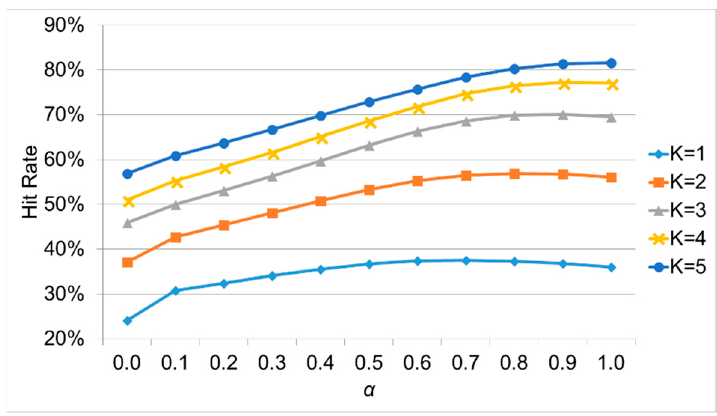
Figure 3. Hit rate as the weight parameter changed.